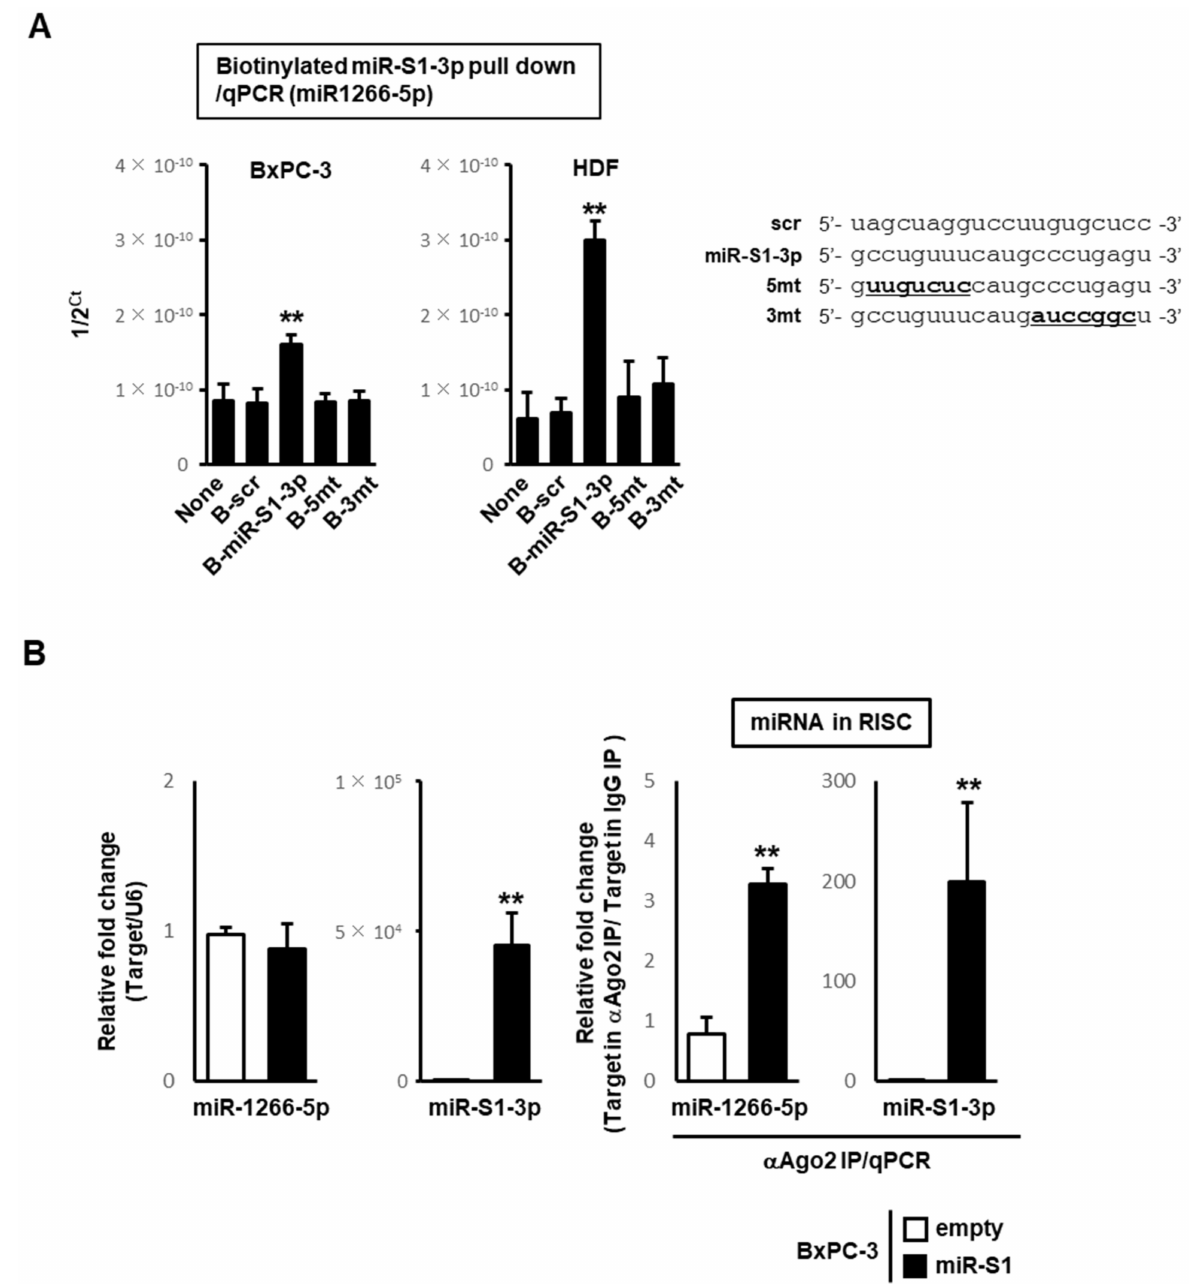
Figure 3. MiR-S1-3p directly binds to endogenous miR-1266-5p, and trapped miR-1266-5p is se- questered in Ago2-associated RISC. ( A ) Lysates from biotinylated scramble sequence, miR-S1-3p, 5mt, and 3mt-transfected cells were pulled down with streptavidin-conjugated magnetic beads, and then RNAs were isolated. Using these RNAs, the levels of miR-1266-5p were determined by RT-qPCR. The Sequence of miR-S1-3p, 5mt, and 3mt (underlined) was also shown (right). All experiments were repeated two times. Columns, mean values ( n = 3); bars, SD; ** p < 0.01. ( B ) Total RNAs from control and miR-S1-expressing BxPC-3 were subjected to RT-qPCR for miR-1266-5p and miR-S1-3p, respec- tively. In parallel, lysates from control and miR-S1-expressing BxPC-3 were treated with anti-Ago2 antibodies, precipitated with protein G-conjugated magnetic beads, and then RNAs were isolated. Using these RNAs, their levels of miR-1266-5p and miR-S1-3p were determined by RT-qPCR. All experiments were repeated two times. Columns, mean values ( n = 3); bars, SD; ** p <